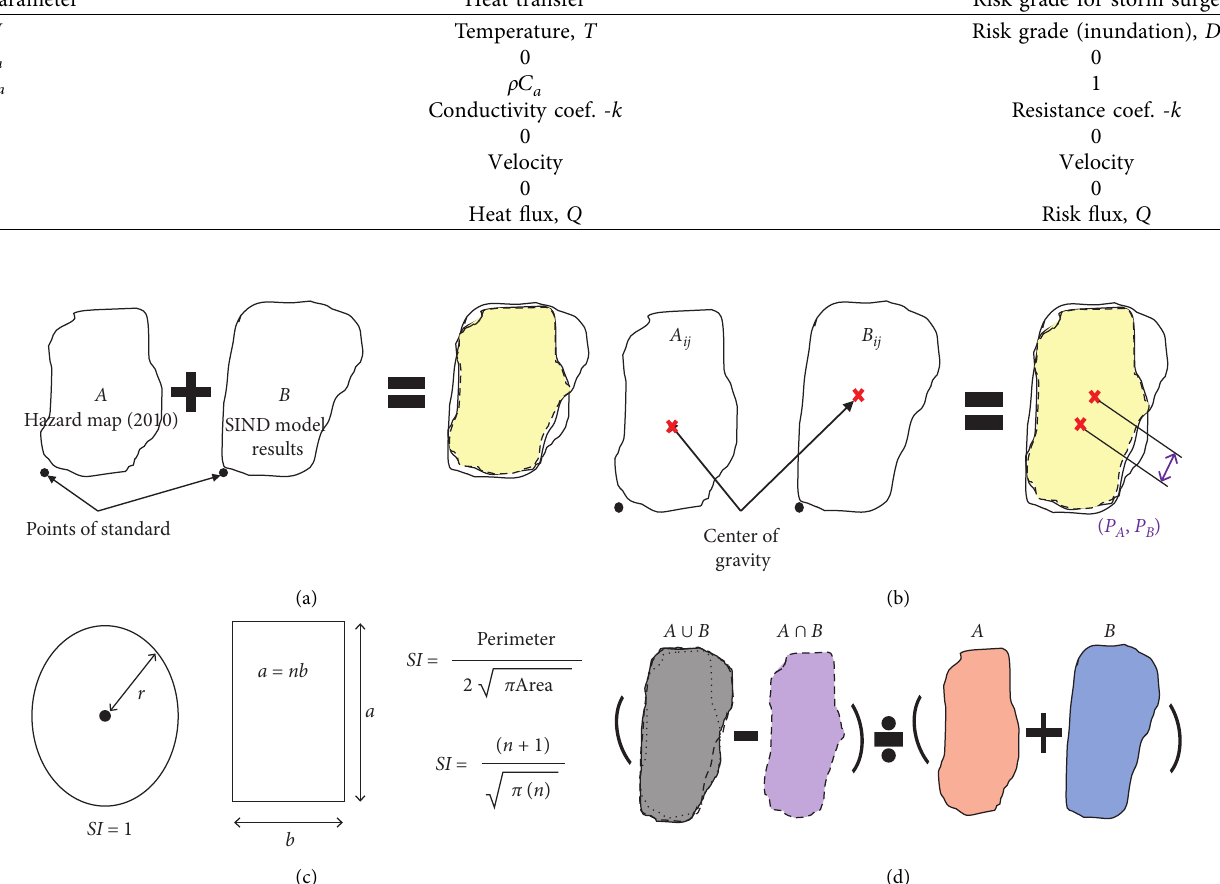
Figure 4: Concept of the CRITIC method. (a) Matching coupled object. (b) Position criterion: center of gravity. (c) Shape criterion: shape index. (d) Area criterion: ratio of overlapped